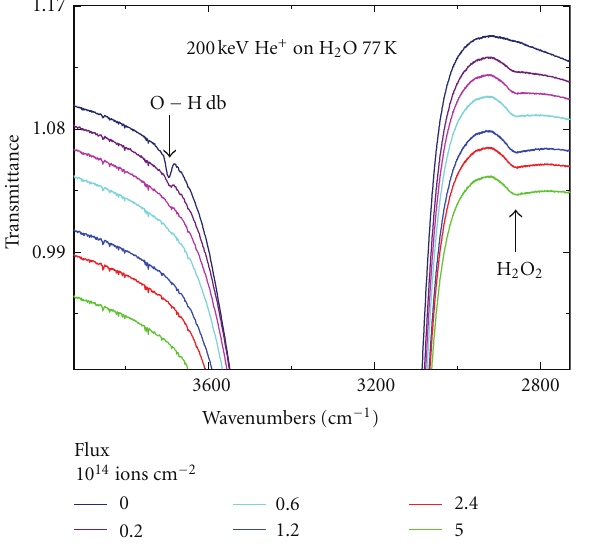
Figure 3: IR spectra (shifted for clarity) of H 2 O ice as deposited and after irradiation with 52MeV Ni +13 at 15K. It is clear the appearance, upon irradiation, of a band at about 2850 cm − 1 easily attributed to H 2 O 2 .